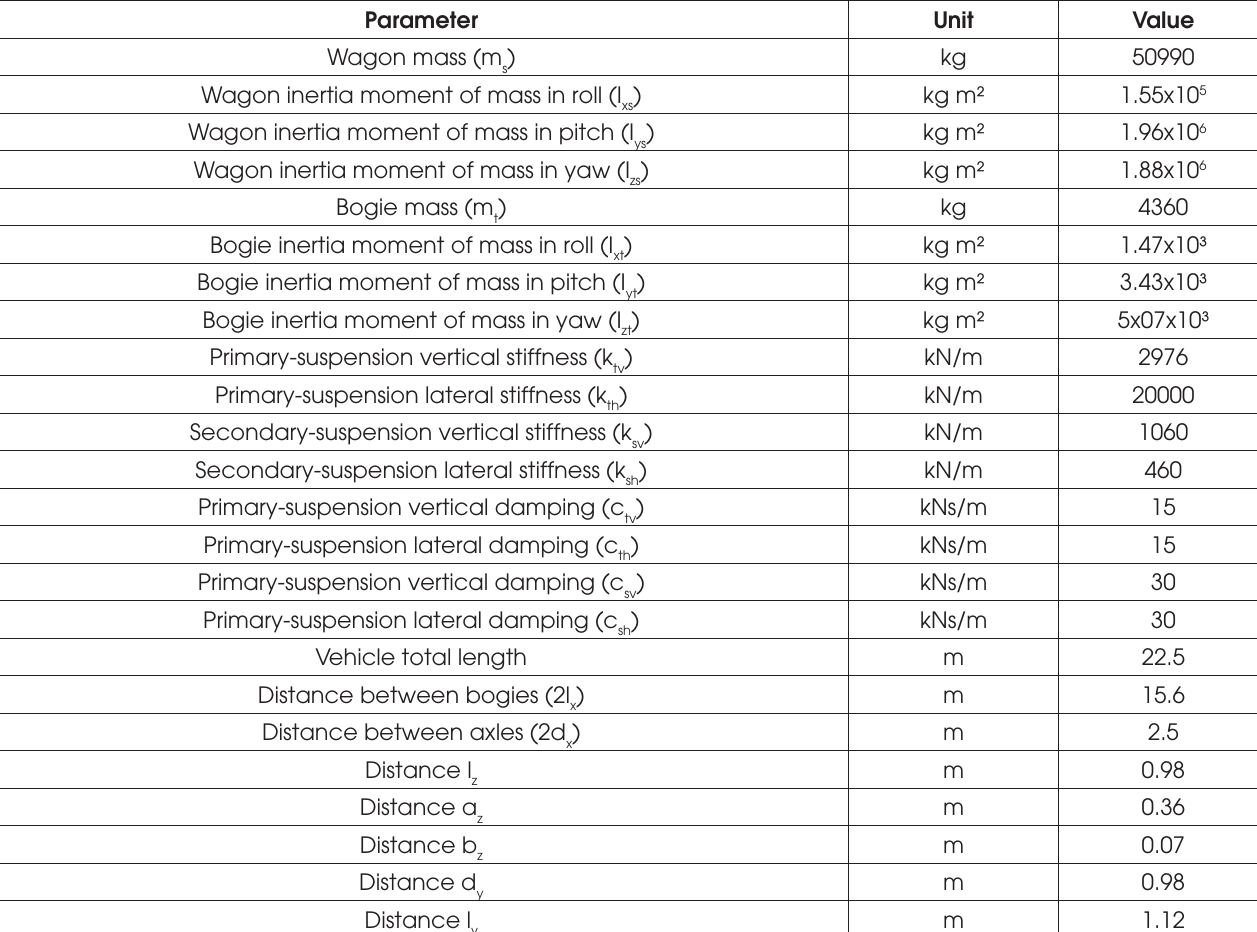
Car mechanical and dynamic parameters